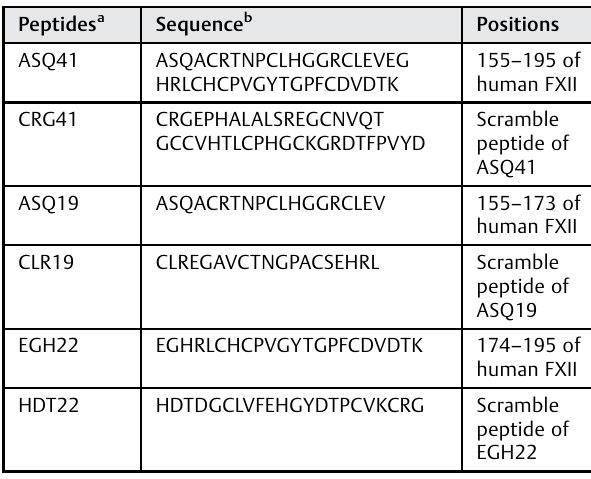
Table 1 Synthetic peptides used in the